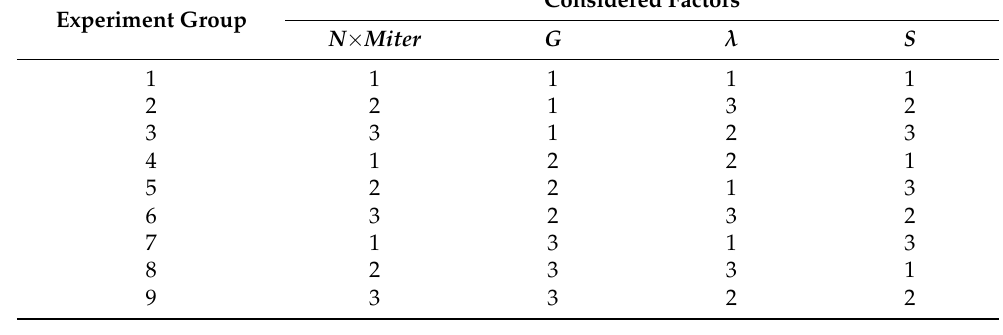
Table 6. Taguchi orthogonal table.